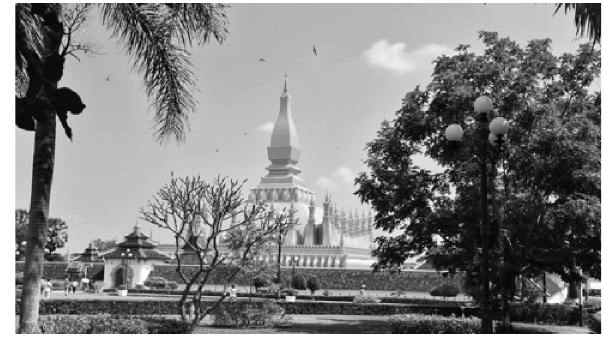
Figure 8. The matrix size of grey image is 276 × 490.